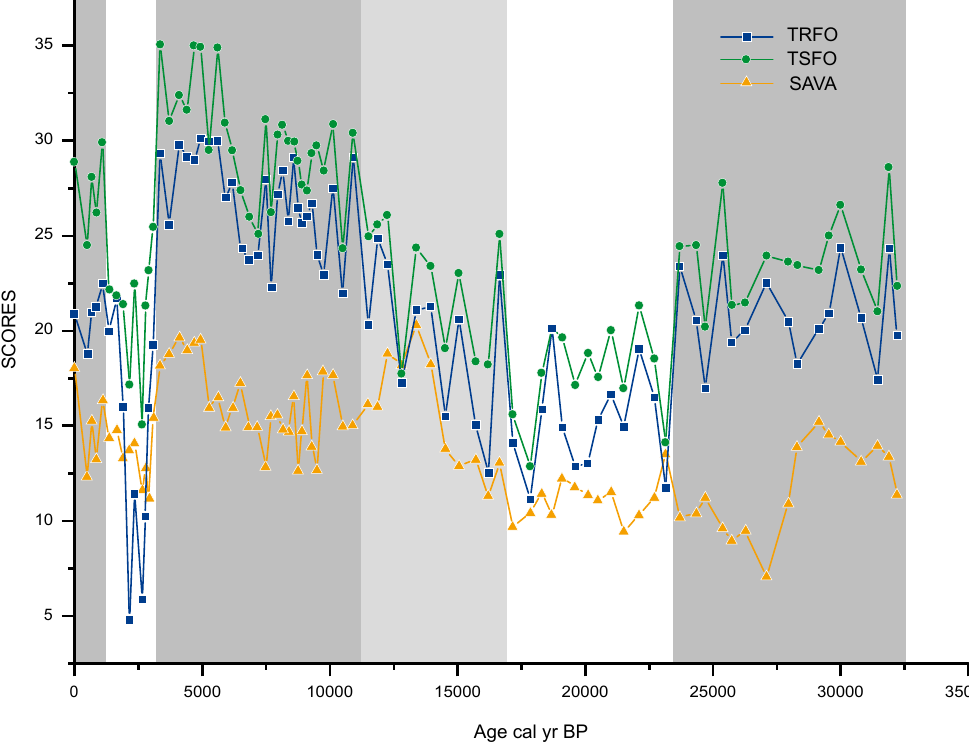
Fig. 4. Reconstructed potential biomes along the Barombi Mbo pollen sequence. TRFO (Tropical Rain FOrest), TSFO (Tropical Seasonal FOrest), SAVA